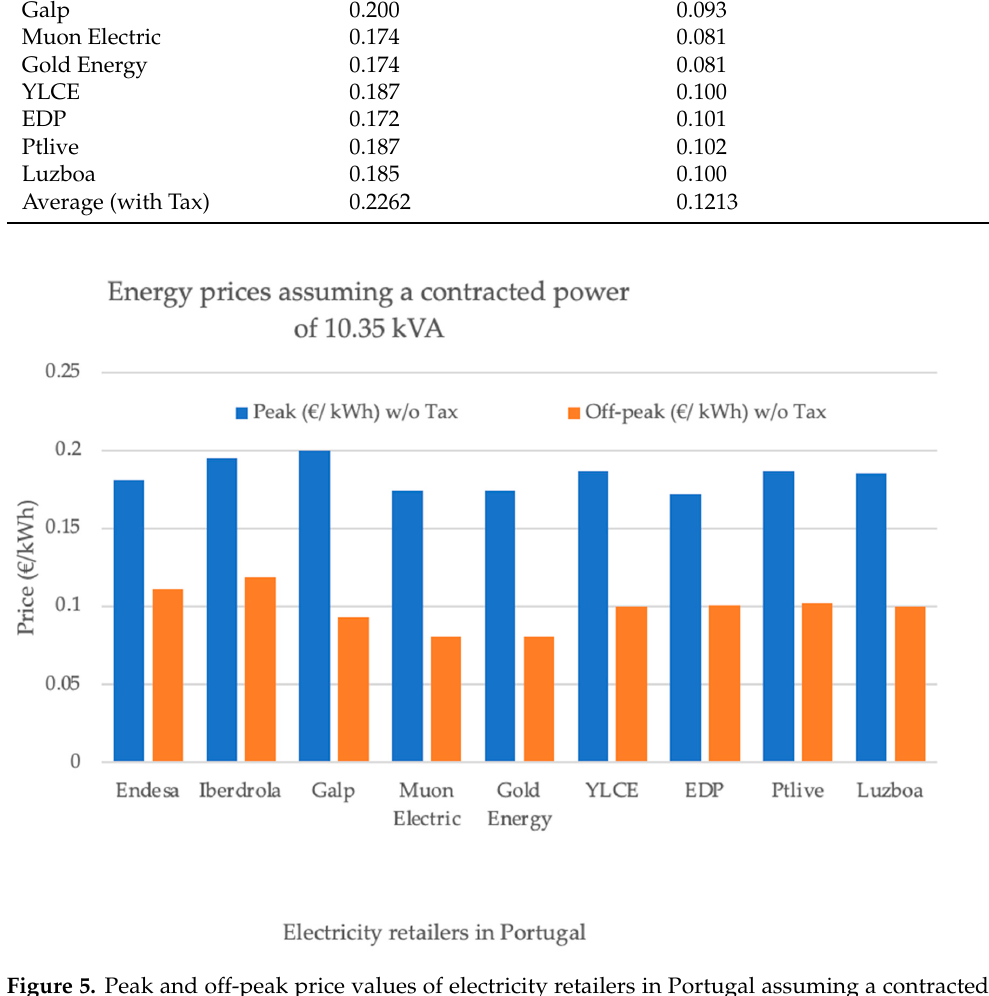
Figure 5. Peak and off-peak price values of electricity retailers in Portugal assuming a contracted power of 10.35 kVA [45].